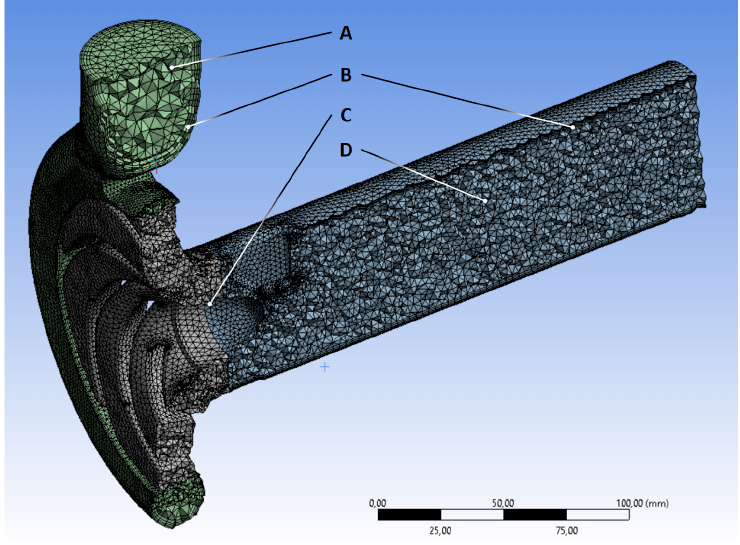
Figure 3. Mesh structure of the computational model. ( A )—coarse mesh, ( B )—inflation, ( C )—fine mesh, ( D )—mesh with global setting.